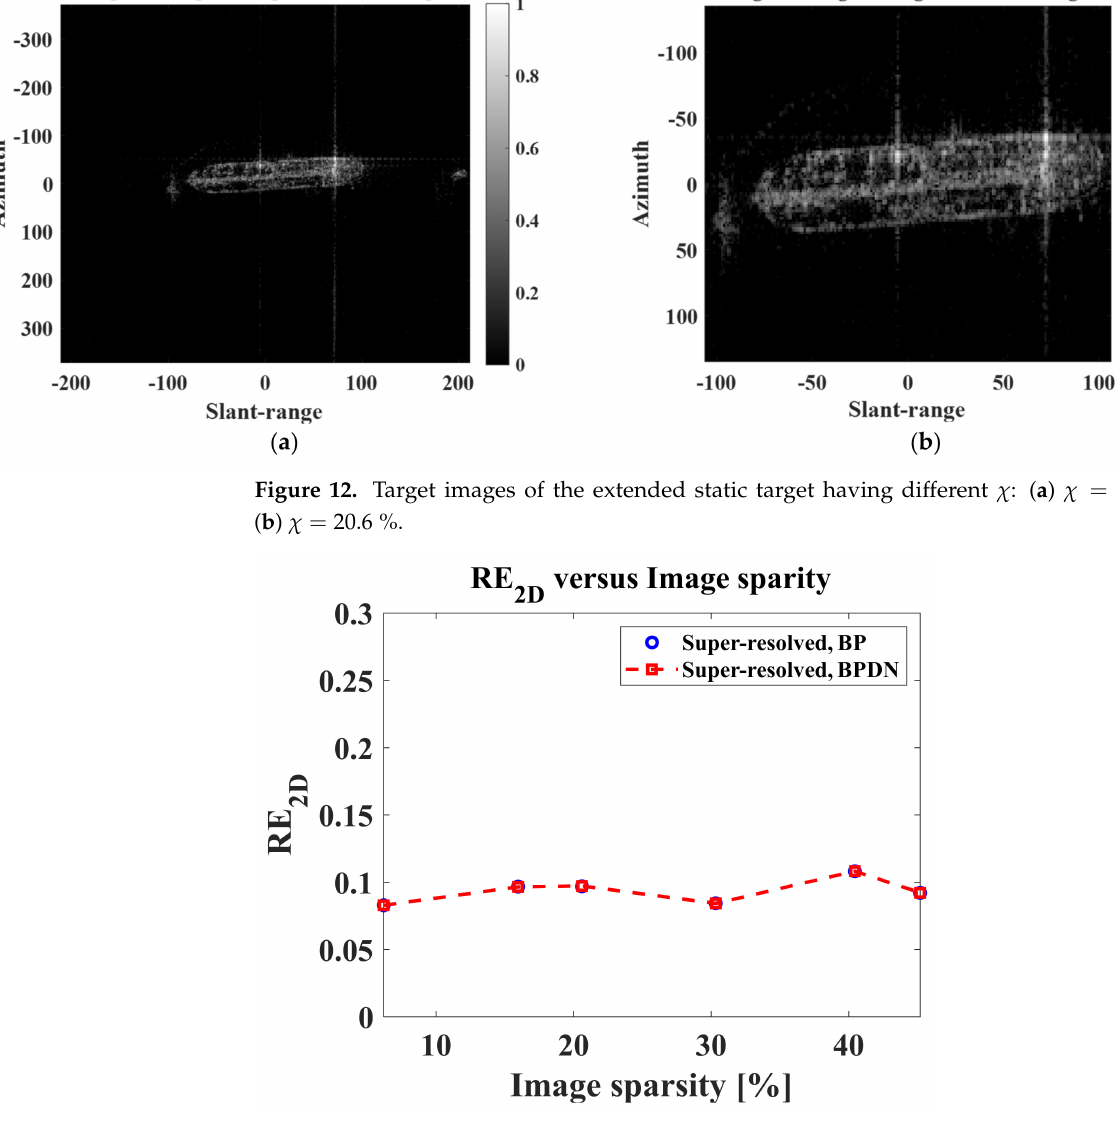
Figure 13. RE 2 D versus χ for target images of extended moving targets in Figure